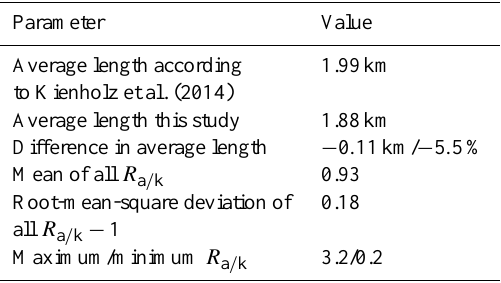
Table 2. Comparison of glacier length calculated by this study and Kienholz et al. (2014) for 21720 glaciers. R a / k denotes the ratio of length measured by our approach to length according to Kienholz et al.